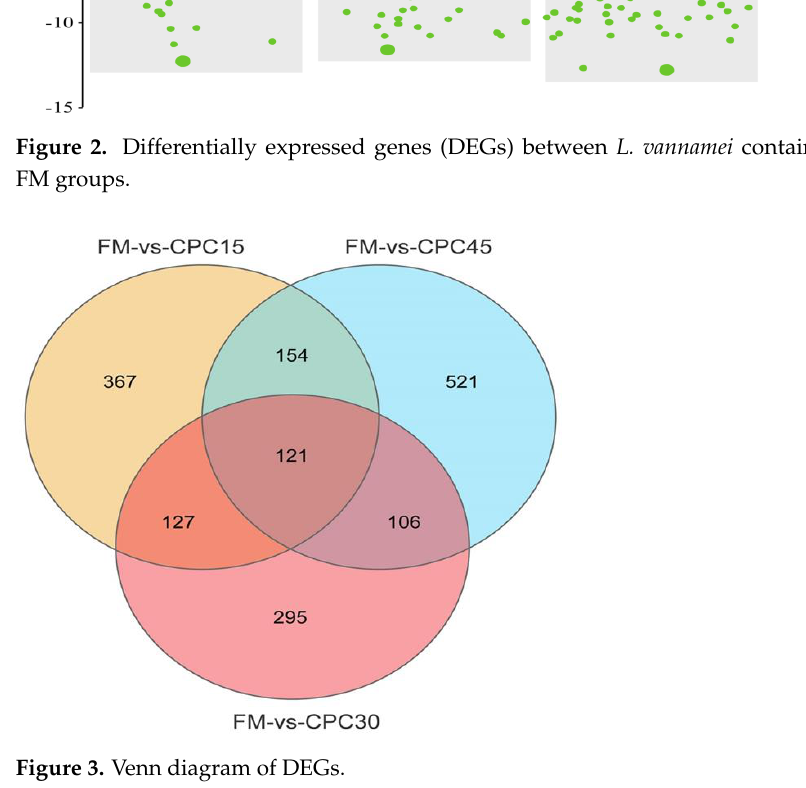
Figure 3. Venn diagram of DEGs.